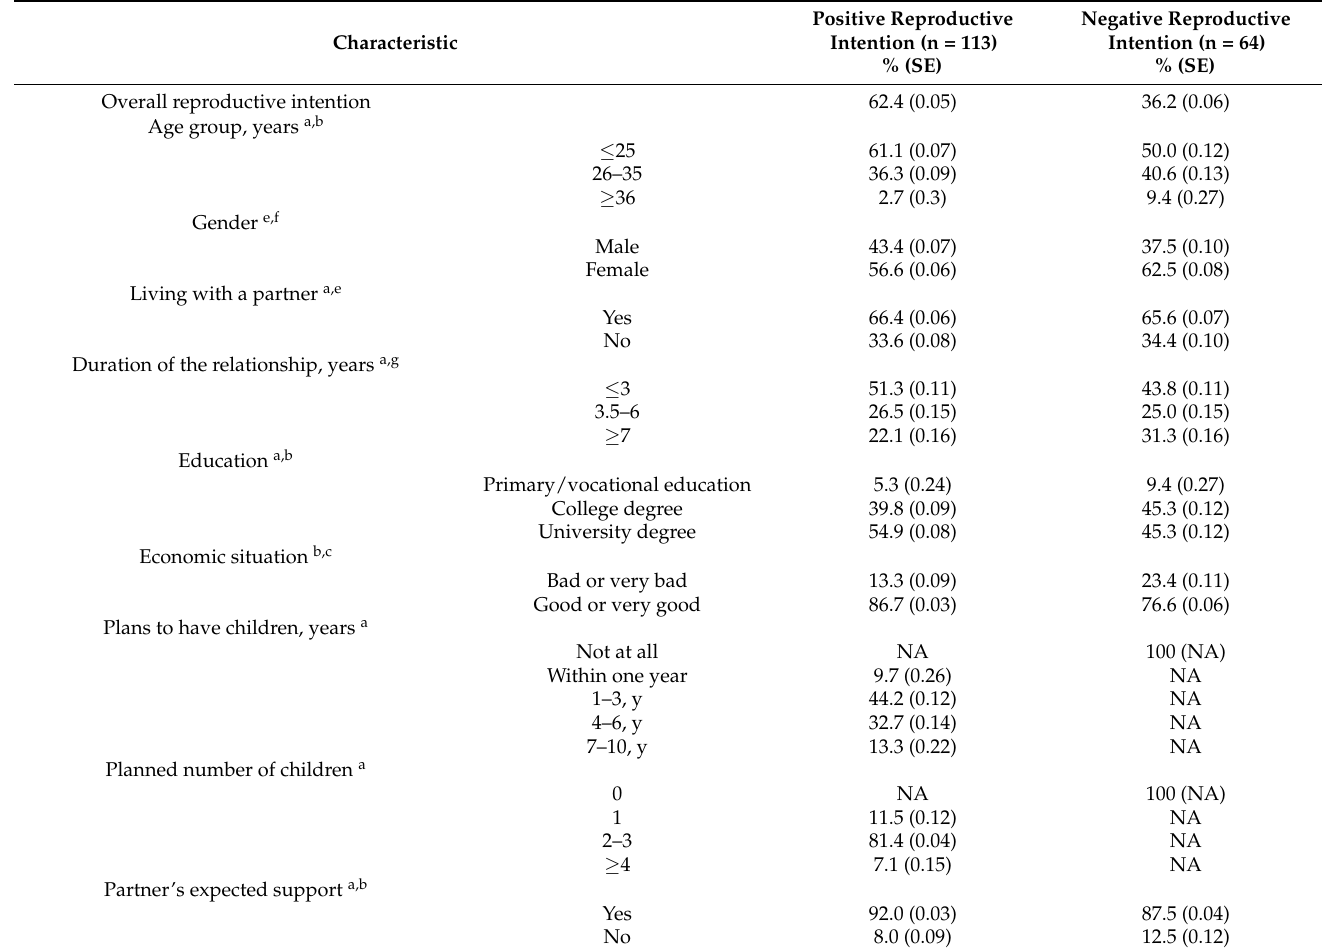
Table 3. Negative and positive reproductive intention by study sample characteristics (N =